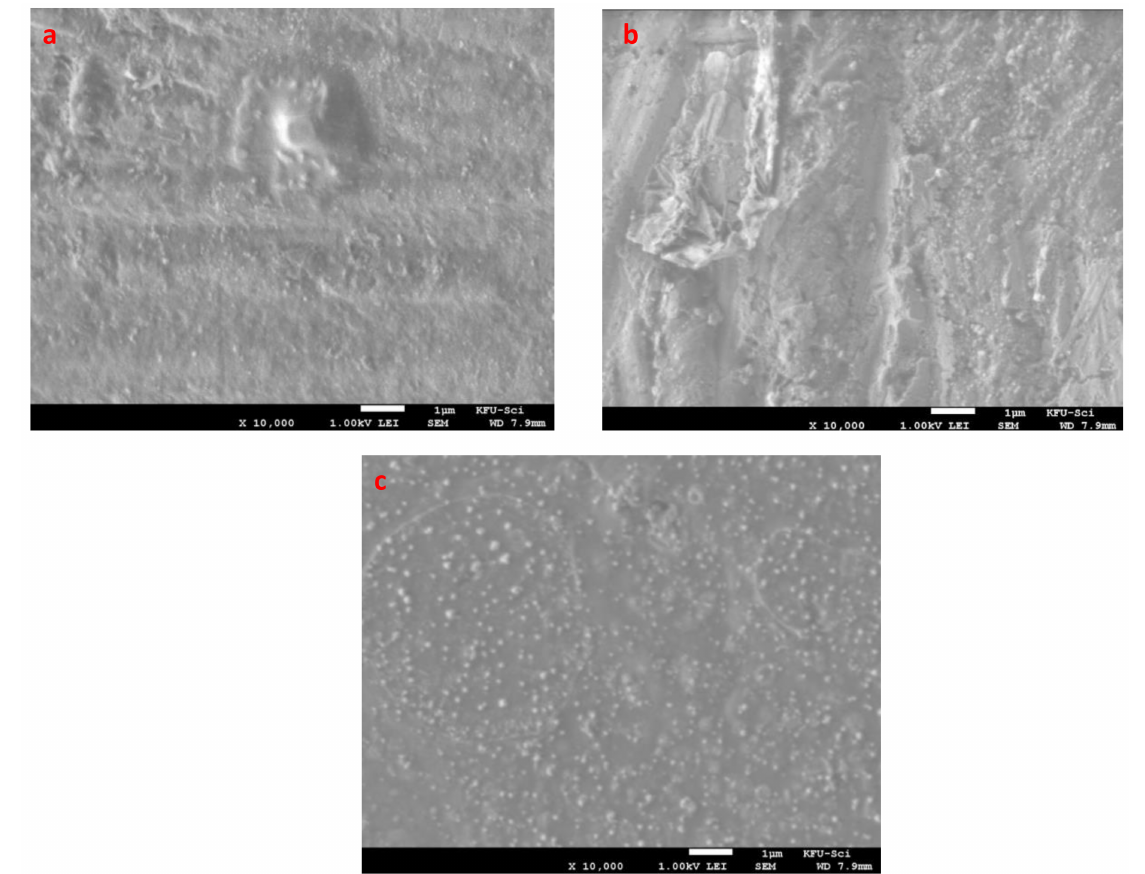
Figure 2. SEM images of pure PVA ( a ), PVA/LiCl film ( b ) and PVA/AgNO 3 film ( c